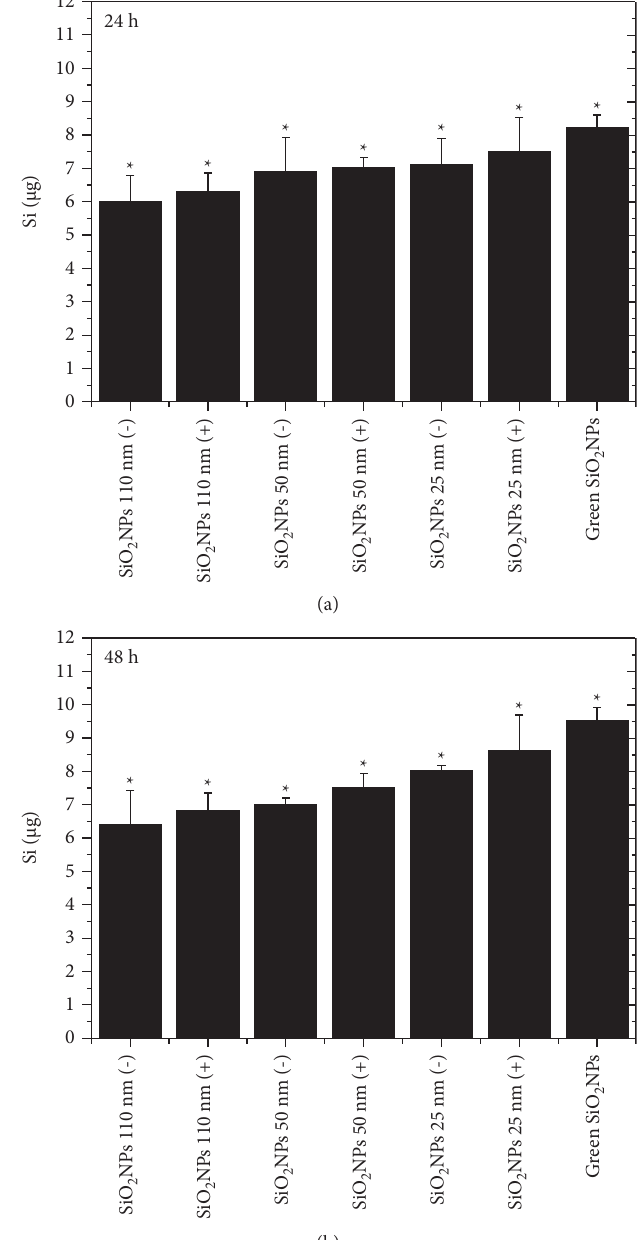
− ), SiO 2 NPs 110nm ( 2 NPs 110nm (+), SiO 2 NPs